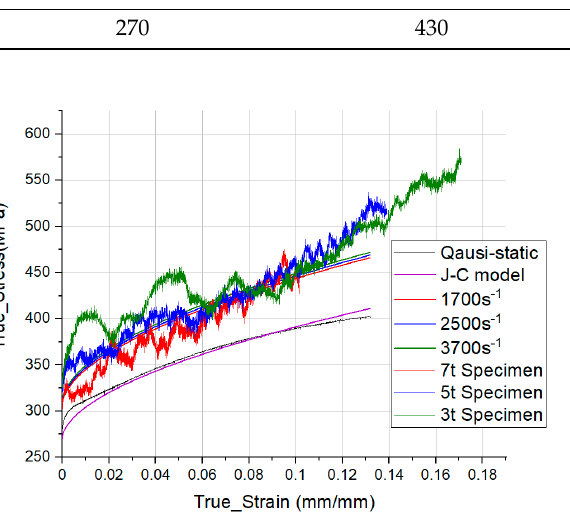
Table 5. Johnson-Cook model parameters of Al6061-T6.